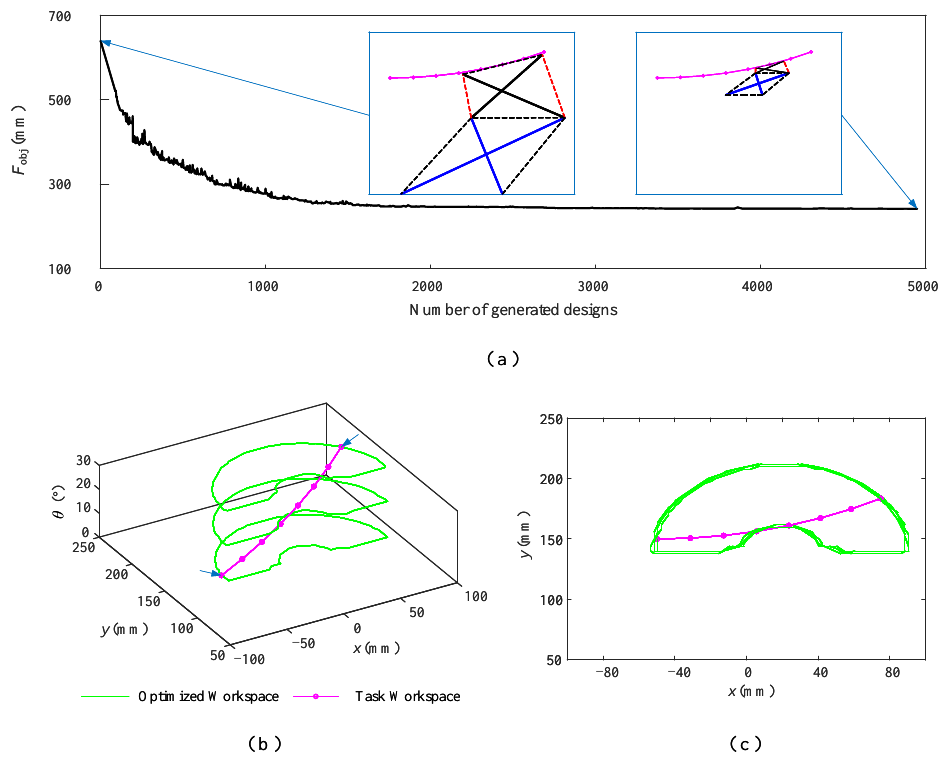
Figure 10. Workspace of the optimized configuration and task workspace (Example 1). ( a ) Optimiza- tion history, ( b ) isometric view, ( c ) top view.